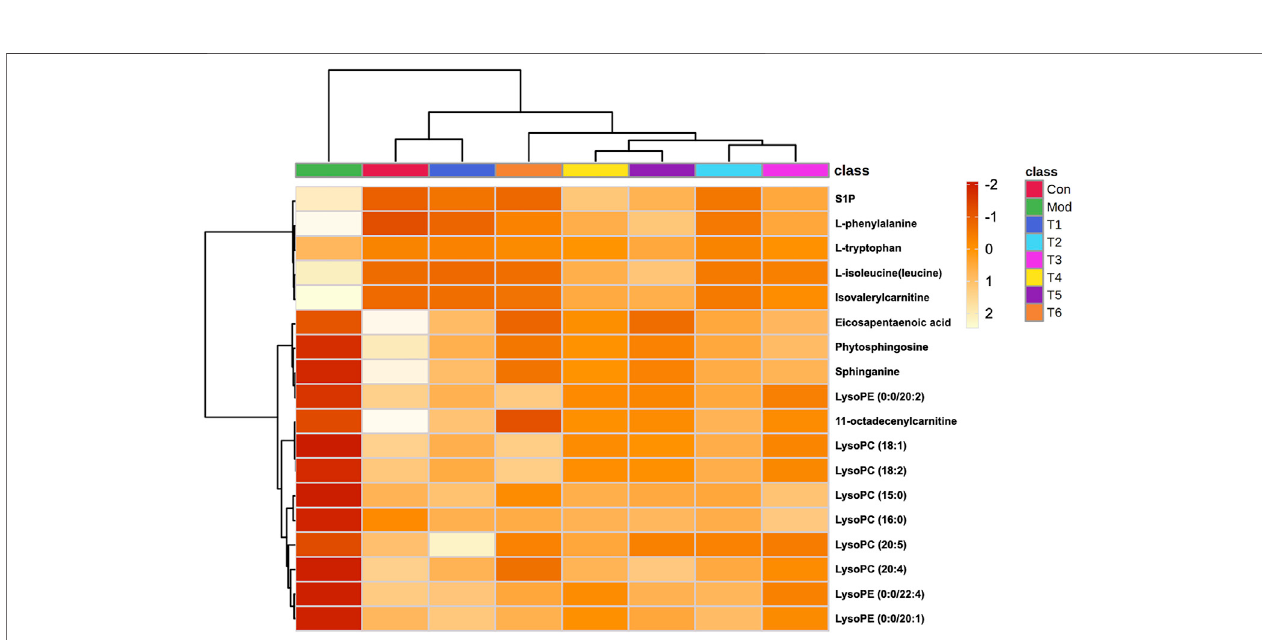
FIGURE 4 | Heatmap with hierarchical clustering analysis showed the change in the biomarkers between each group.